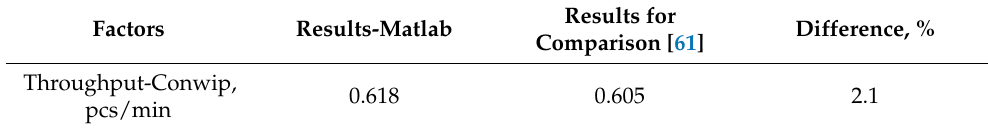
Table 1. Validation of the model.